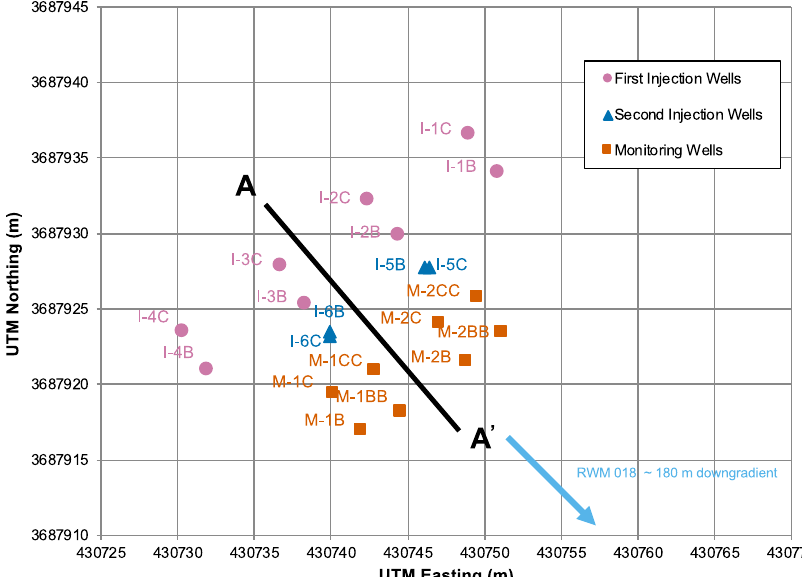
Fig. 7 Map of injection wells and proximal monitoring wells for oxidant injection pilot test. Reddish purple circles mark the locations of the injection wells used in the fi rst test. Blue triangles mark the location of the injection wells used in the second test. Vermillion squares mark the locations of the proximal monitoring wells. The black line indicates the direction of groundwater fl ow from A to A ’ and is used to mark the cross-sectional view in Fig. 8. The sky blue arrow in the direction from A to A ’ indicates that recovery well RWM 018 which controls groundwater fl ow in the test area is ~180 m from the injection wells.